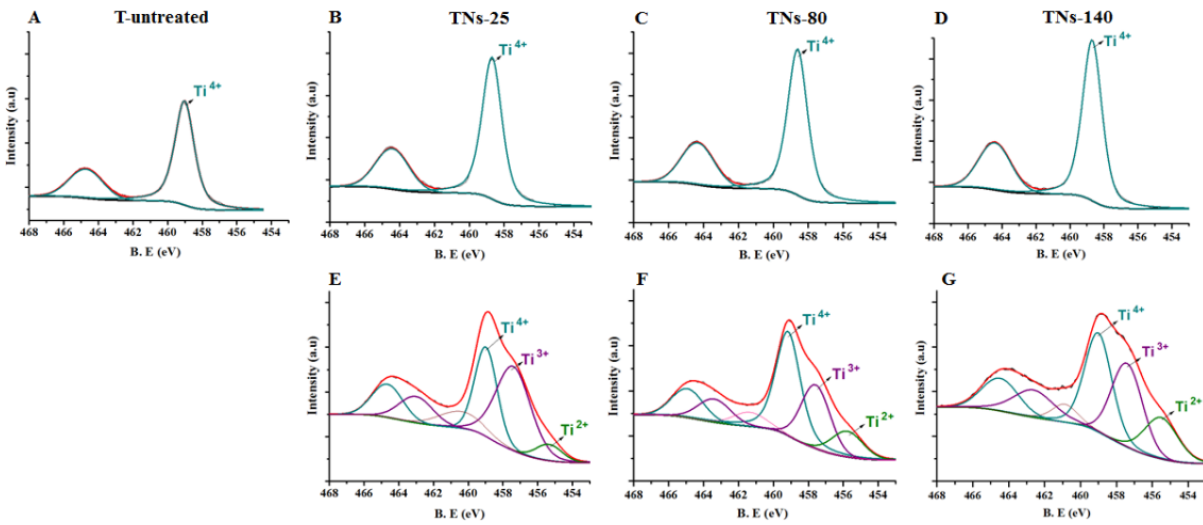
Figure 2. High-resolution XPS spectra of Ti 2p for ( A ) T-untreated, ( B , E ) TNs-25, ( C , F ) TNs-80, and ( D , G ) TNs-140 surfaces ( A – D ) prior to and ( E – G ) after Ar + sputtering.